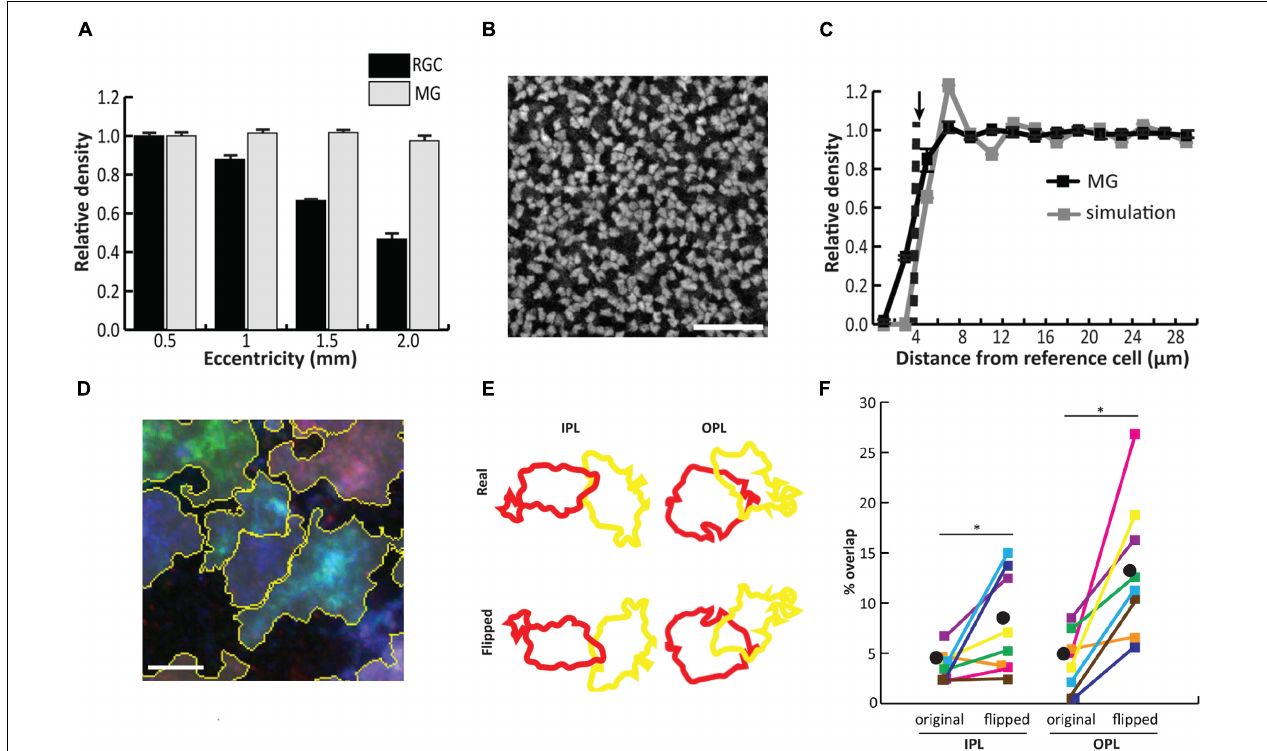
FIGURE 3 | Müller glial (MG) cell bodies are uniformly distributed across the mouse retina and randomly arranged in the tangential plane, while processes in synaptic layers tile the retina with minimal overlap. (A) In contrast to retinal ganglion cells, MG are uniformly distributed across all retinal eccentricities. (B) Staining for the glial marker Sox9 in the inner nuclear layer (INL) reveals tight packing of cell bodies separated by small gaps. (C) Density recovery profile (DRP) for MG cell bodies (black) reveals an exclusion zone which matches the average cell body size. DRP for simulated random arrays (gray) matched in cell size and density to MG corresponds well with the true MG DRP, suggesting random assortment of cell bodies in the INL. (D) Combinatorial expression of multiple fluorescent markers via the Brainbow system followed by contiguous spatial segmentation delineates the territories of individual cells within the inner and outer plexiform layers (IPL/OPL). (E) Arbor overlap between neighboring pairs of MG was calculated before and after flipping each image about its horizontal axis. (F) Arbor overlap is significantly greater when territories are flipped, suggesting non-random arrangement. Scale bars (in µ m): 50 (B) , 5 (D) . Adapted from Wang et al.